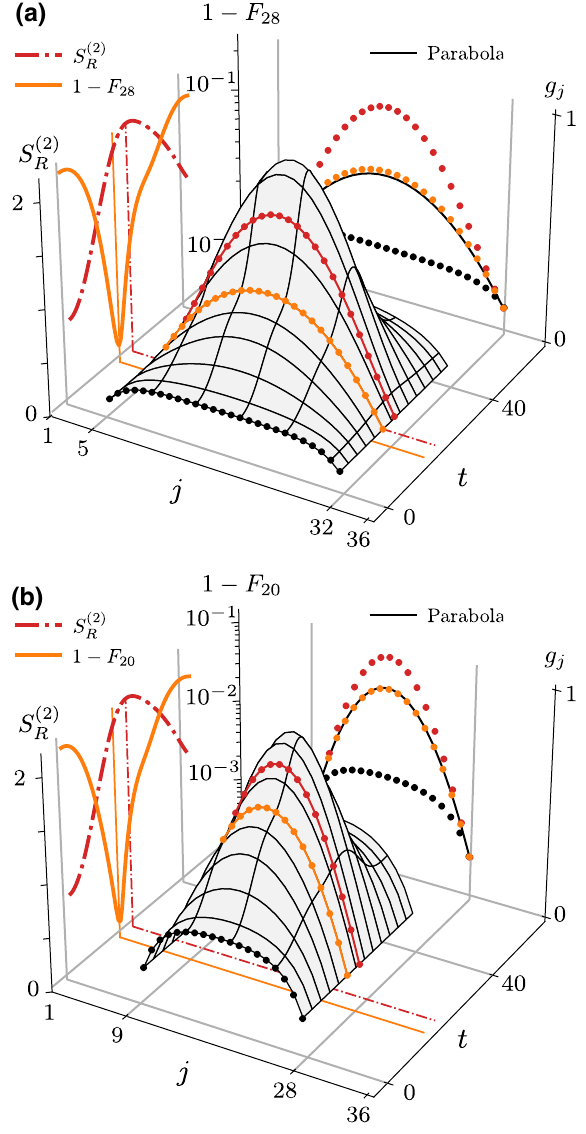
FIG. 6. Parameters g ( n ) of the learned EH ˜ H n = j (cid:2) g ( n ) h j , j + 1 for subsystem A consisting of (a) the sites j j ∈ A j = 5, . . . , 32 ( n = 28) and (b) j = 9, . . . , 28 ( n = 20), starting from an initial thermal state (see text). The projections at the at times corresponding to the initial state (black back show g ( n ) j dots with the lowest amplitude), maximum entropy (red dots with the maximum amplitude), and at the time of the infidelity minimum (orange dots), which are the closest to the parabolic shape (black solid